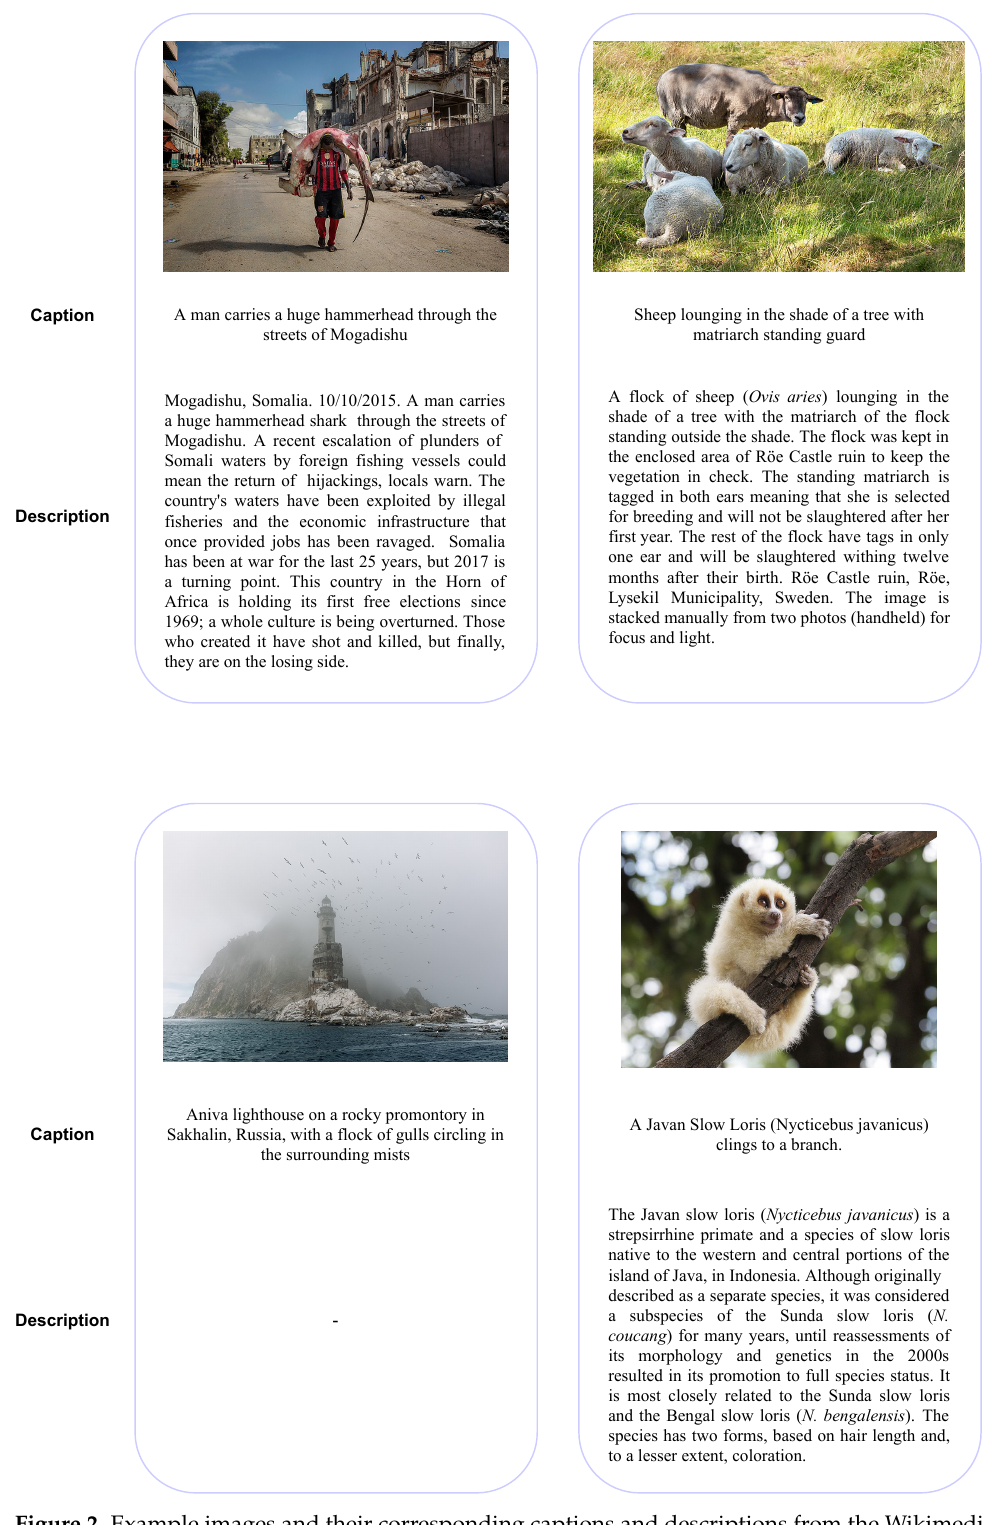
Figure 2. Example images and their corresponding captions and descriptions from the Wikimedia Commons